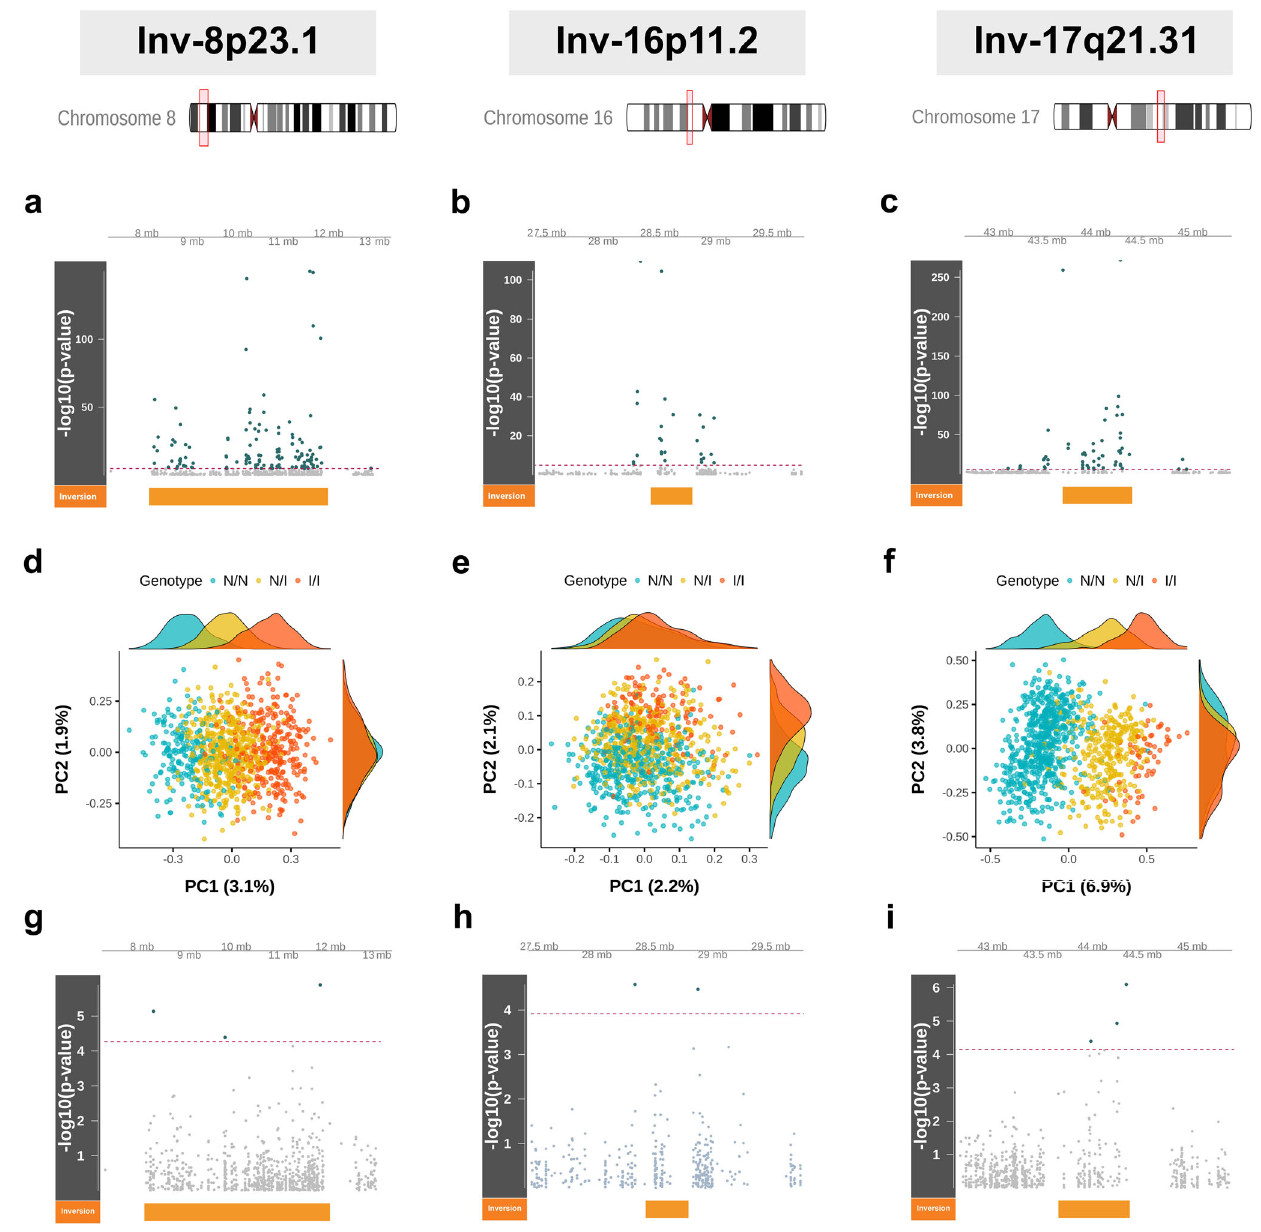
Fig. 1 Inversion status as methylation quantitative trait loci ( mQTL ) of multiple CpG sites within and surrounding three common human inversions. The fi rst column in the plot panel corresponds to inv-8p23.1, the second to inv-16p11.2, and the third to inv-17q21.31. a – c Manhattan plots for the signi fi cance of the associations between the differential methylation of the CpG sites and the inversion genotypes in child blood cells ( N = 1009). The x axes show the chromosome position (±1 Mb between the inversions ’ breakpoints). The y axes show the – log 10 ( P -value). The dashed red line indicates Bonferroni ’ s threshold of signi fi cance. Green points are CpG sites with signi fi cant associations and those in gray are nonsigni fi cant. The orange block illustrates the inversions ’ region. d – f Principal component (PC) analysis for methylation levels of CpG sites within and surrounding the inversions, revealing remarkably distinctive methylation patterns among the different inversion statuses. Blue points illustrate noninverted homozygous (N/N), yellow illustrates heterozygous (N/I), and orange illustrates inverted homozygous (I/I) individuals. In parenthesis, the methylation variance explained by each PC. g – i Manhattan plots of differentially methylated CpG sites, depending on the inversion genotypes in fetal heart DNA ( N =